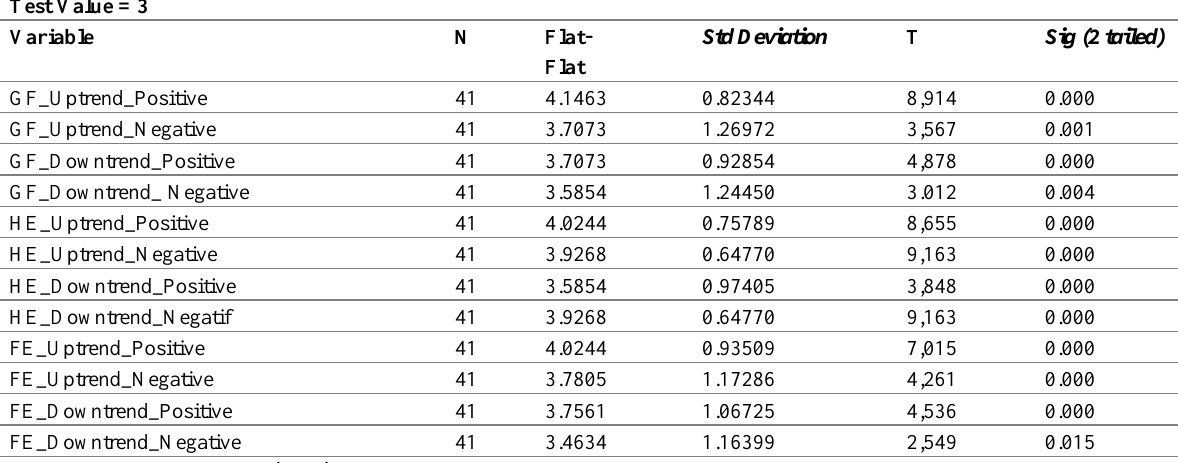
Table 1: One Sample T-Test